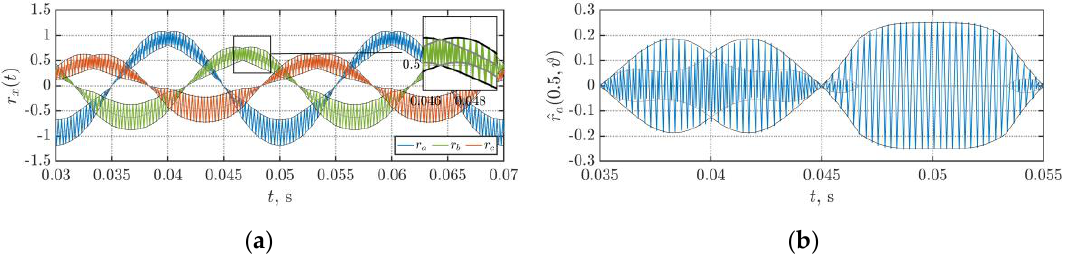
Figure 11. Primary (black) and secondary (gray) envelopes in case of DPWMMIN at m = 0.5 and f sw = 3.6 kHz: ( a ) Normalized phase currents; ( b ) Normalized phase current ripple.